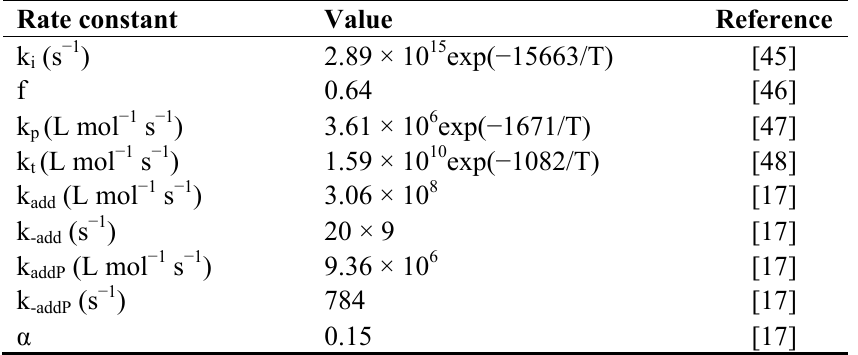
Table 10. Rate constants cumyl dithiobenzoate mediated methyl acrylate